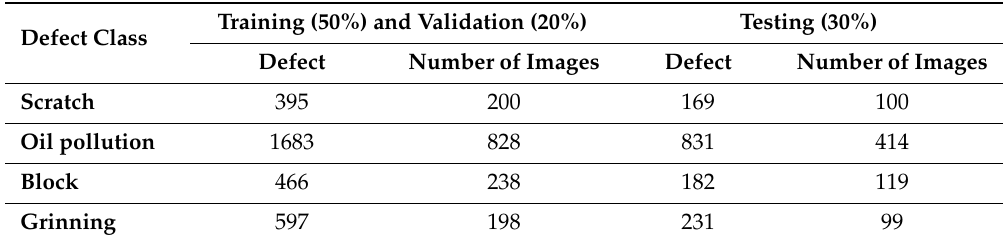
Table 1. The proportion of training, validation, and testing sets.